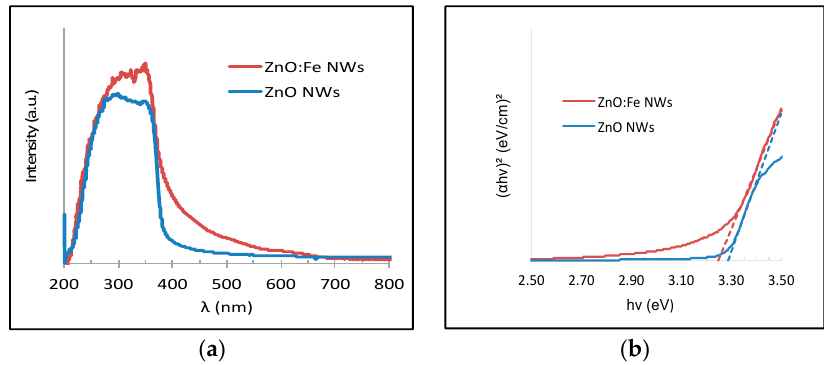
Figure 4. ( a ) UV-Visible absorption spectra of undoped and Fe-doped ZnO NWs; ( b ) Tauc plot showing a narrowing of ZnO NWs band gap after iron doping.